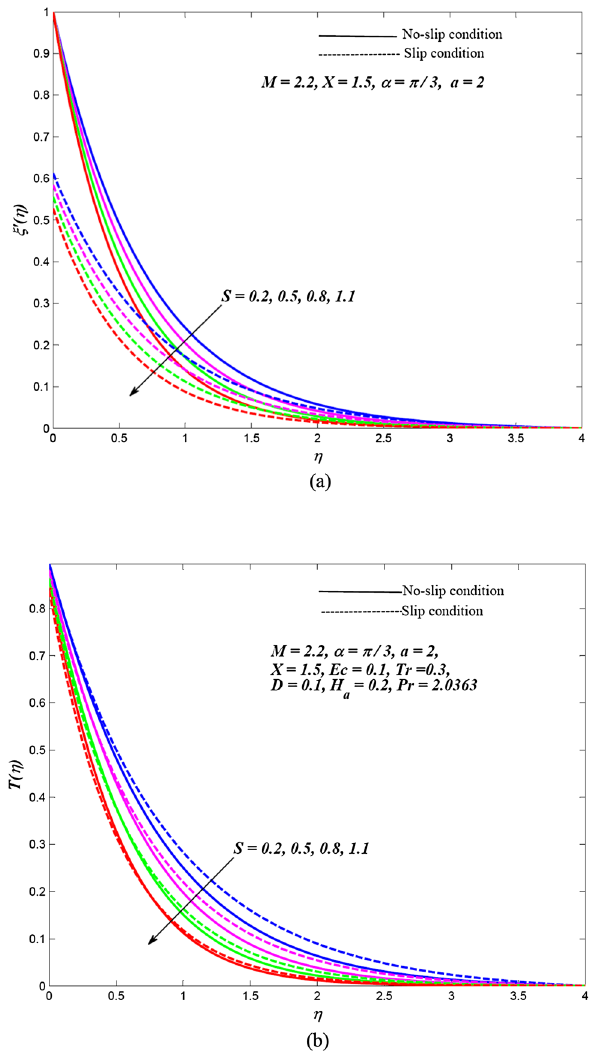
Figure 4. Effects of S (> 0 ) on the dispersal profiles of hybrid ( a ) velocity ξ ′ (η) and ( b ) temperature T (η)